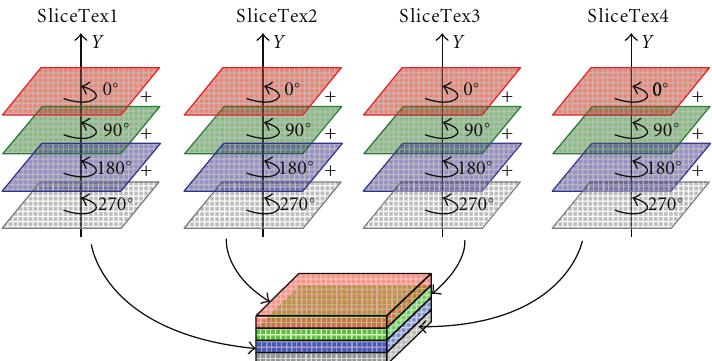
Figure 4: Strategies for slices accumulating and packing.